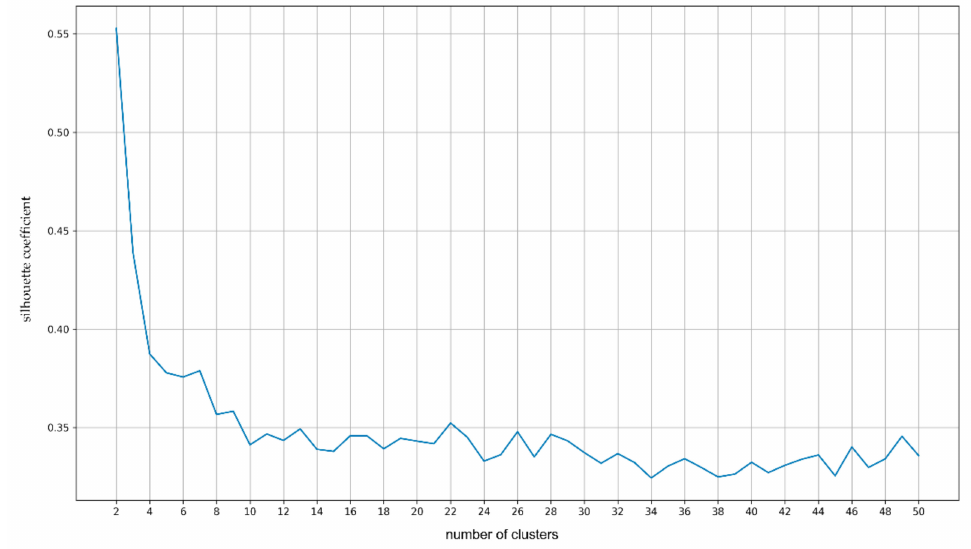
Figure 6. Estimation of variation by the number of distributions using the silhouette